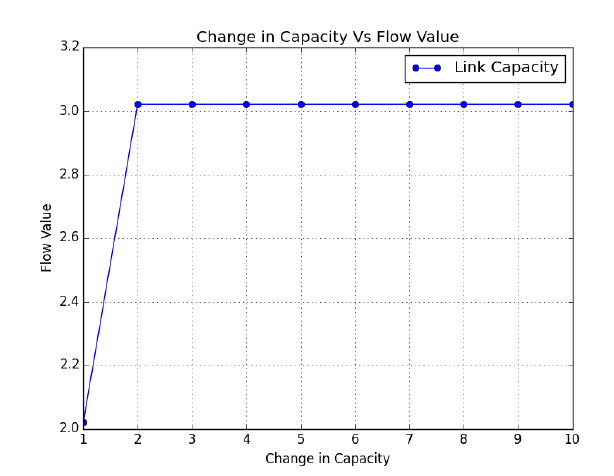
Figure 4. Change in Flow Value with change in Link Capacity Value